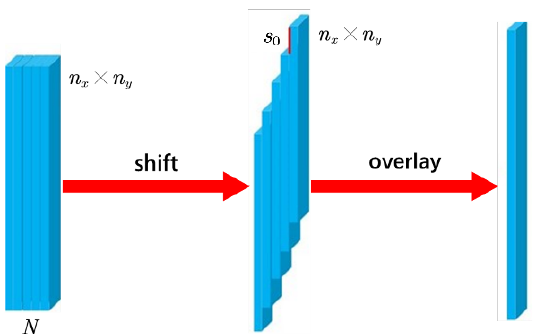
Figure 4. For a data cube of size n x × n y × N . Its height is n x , width is n y , and the number of frames is N . Then, the compressed image size is [( N − 1 ) s 0 + n x ] × n y .